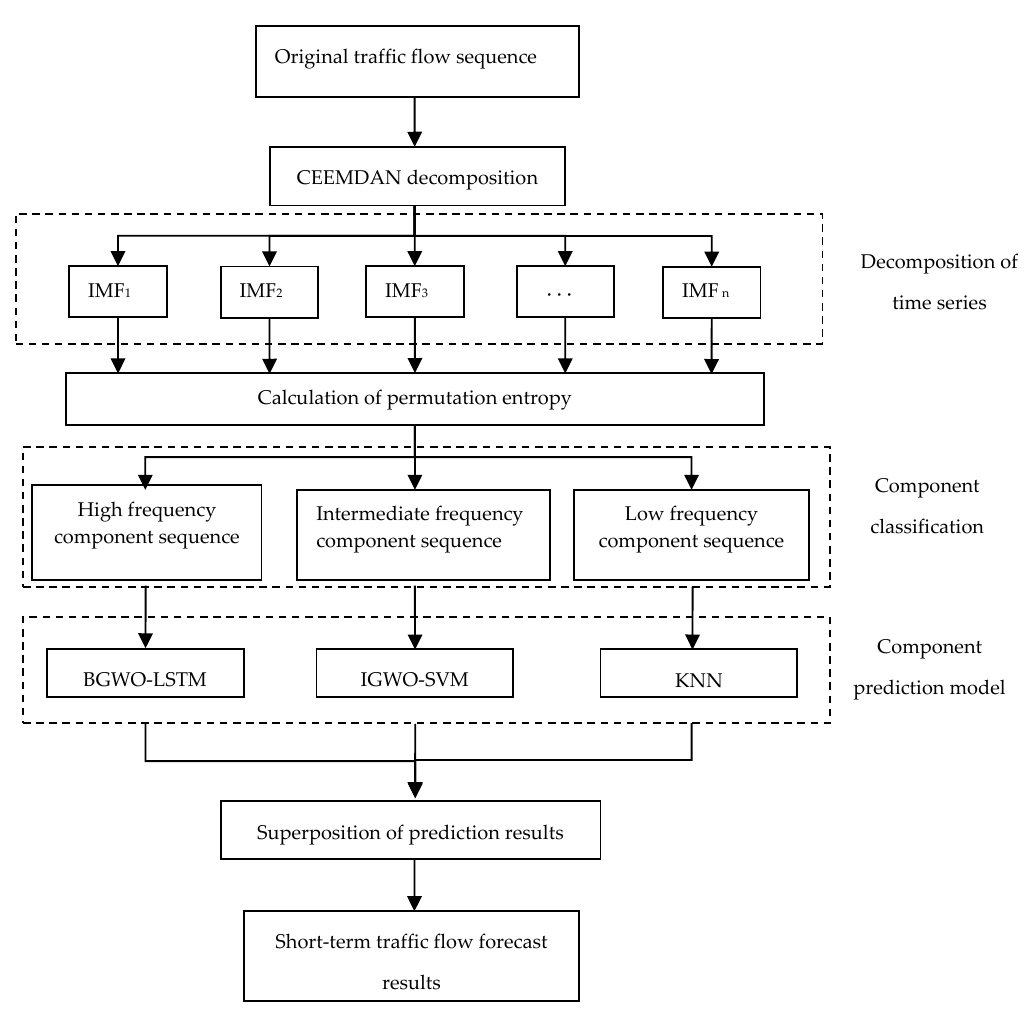
Figure 4. Flowchart of short-term traffic flow prediction model based on CEEMDAN and machine learning.